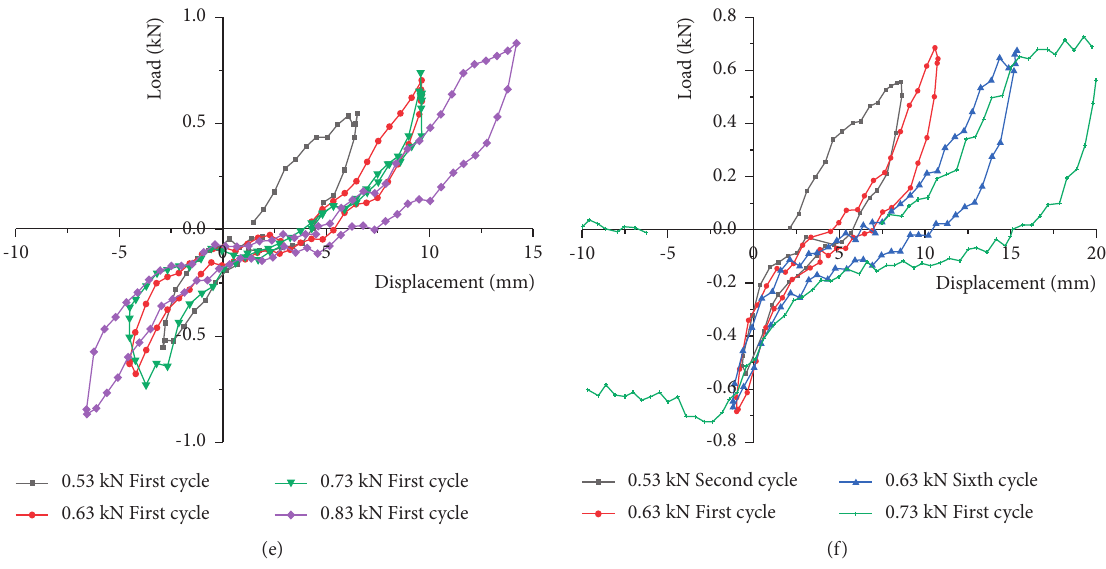
Figure 13: Hysteretic loop morphology under different load levels. (a) LK1. (b) LK2. (c) LK3. (d) KZ1. (e) ZZ1. (f)